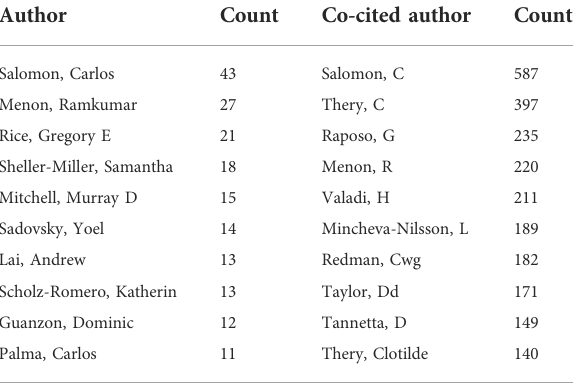
TABLE 3 Top 10 authors and co-cited authors on exosomes in